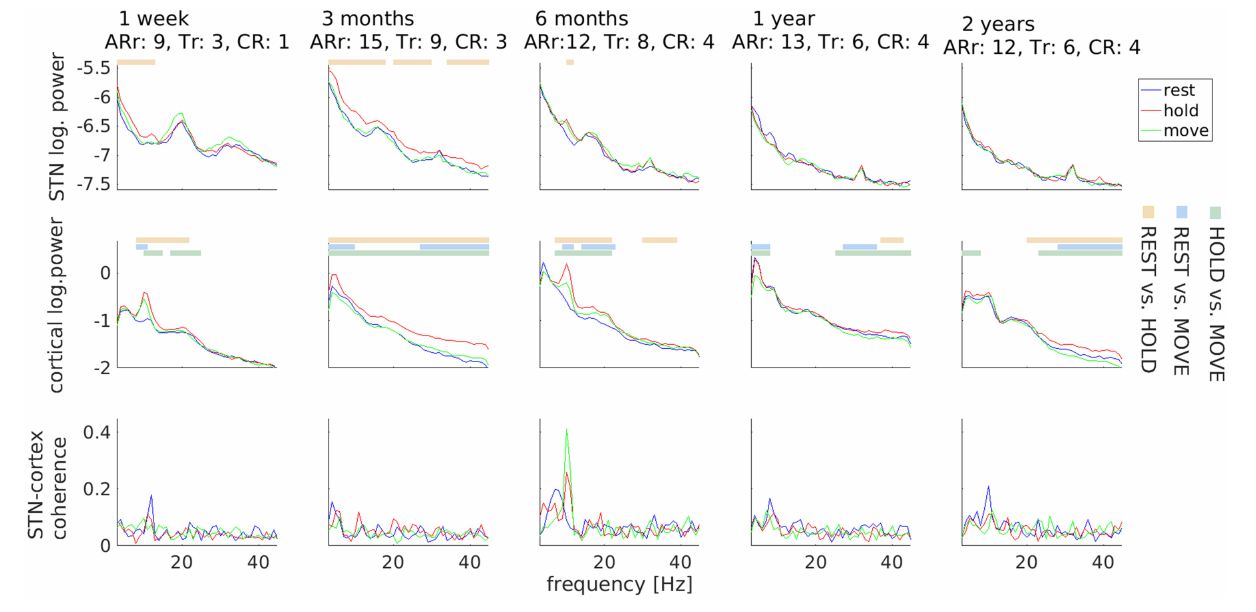
FIGURE 2 | Temporal stability of subthalamic and cortical oscillations. Motor tasks are color-coded. Horizontal lines mark significant differences and comparisons are coded by another color scheme (see legends on the right). Values underneath the row titles indicate body side-specific scores for akinesia/rigidity (ARr; UPDRS III items 3.3–3.8) and for tremor (Tr: UPDRS III items 3.17) for the right body side, i.e., contralateral to local field potential recordings, and for the constancy of rest tremor (CR: UPDRS III item 3.18). Clinical scores obtained 3 months before surgery: ARr: 10, Tr: 8, CR: